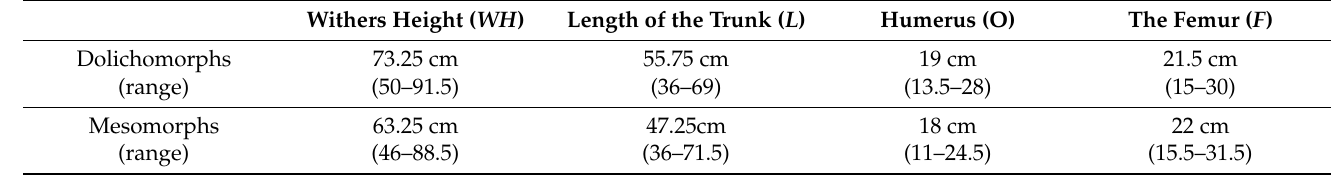
Table 4. Morphometric measurement in cm expressed as median (range).